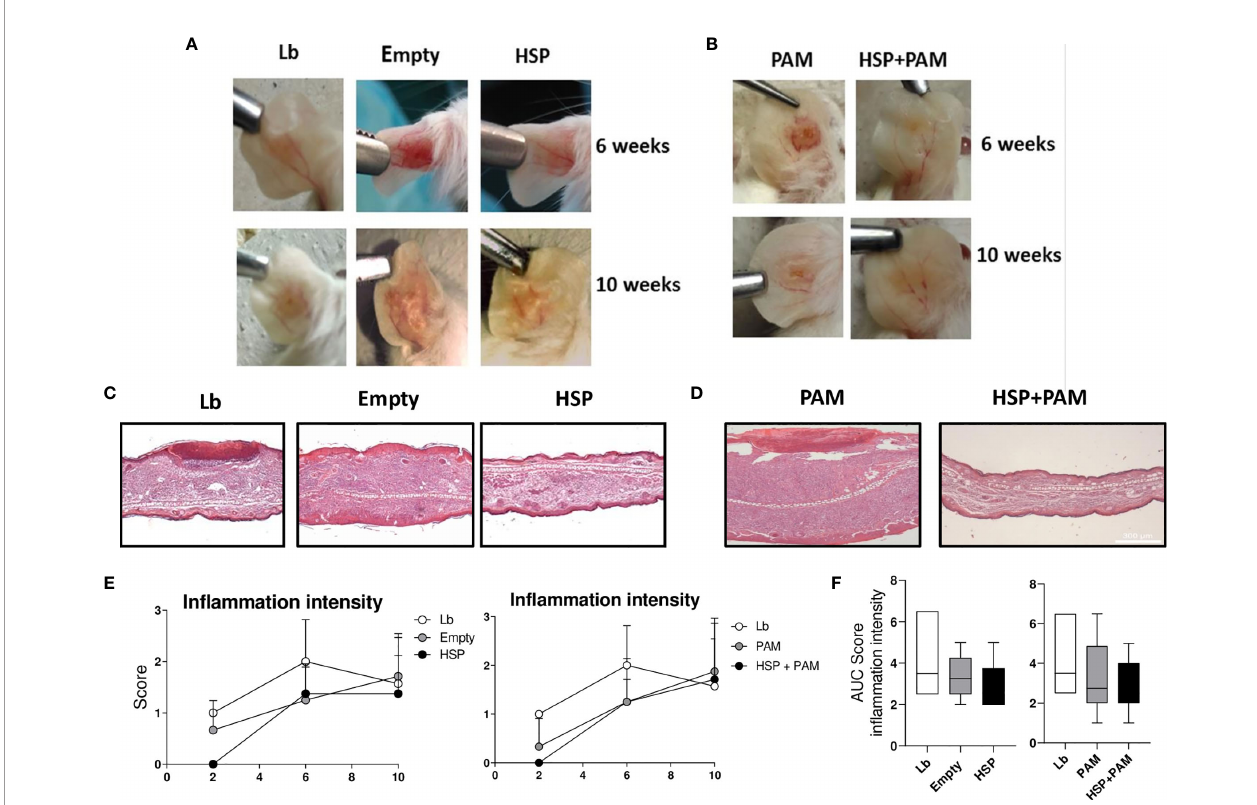
FIGURE 5 | Lesion appearance, histological evaluation and quantitative score of in fl ammation intensity. Mice were treated with water (Lb and PAM), GM17 medium with empty-vector-bearing L. lactis (Empty) or XM17 medium containing Hsp65 - producing L. lactis (HSP and HSP+PAM) for 4 consecutive days, then inoculated 10 days later with L. braziliensis metacyclic promastigotes in the ear. Two days prior to infection, the HSP+PAM and PAM groups received an intraperitoneal administration of PAM3CSK4. For nonparametric data, Kruskal-Walliis with Dunn ’ s post-test was used. (A, B) Representative lesion aspects at 6 and 10 weeks after infection in respective animal groups. (C, D) Ears were collected, fi xed in 10% formaldehyde, processed and stained with hematoxylin and eosin. All sections were evaluated for histopathological changes, including in fl ammation intensity and the presence of in fl ammatory cell in fi ltrate. Scores for this parameter were determined according to intensity: Scores for each parameter were determined according to intensity: 0 (absence), 1 (presence of 1-25%), 2 (presence of 25-50%) and 3 (> 50%). Healthy animal ears were used as a negative control. (E) Kinetics of histological parameters in Lb, Empty and HSP groups (left panel) and Lb, PAM and HSP+PAM (right panel). Data are representative of means from each group. (F) Area under the curve analysis of histological scores obtained for each parameter evaluated. Quantitative scores are represented as medians and interquartile range. Data are representative of four independent experiments involving 8 animals per group. For nonparametric data, Kruskal-Wallis with Dunn ’ s post-test was used, no signi fi cance was